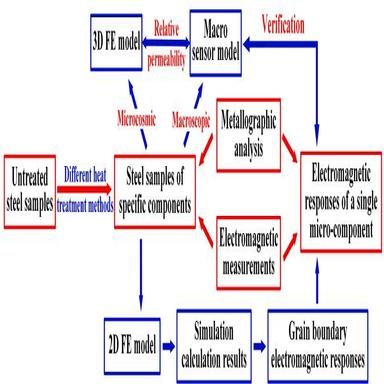
Experimental and modelling process flowchart.